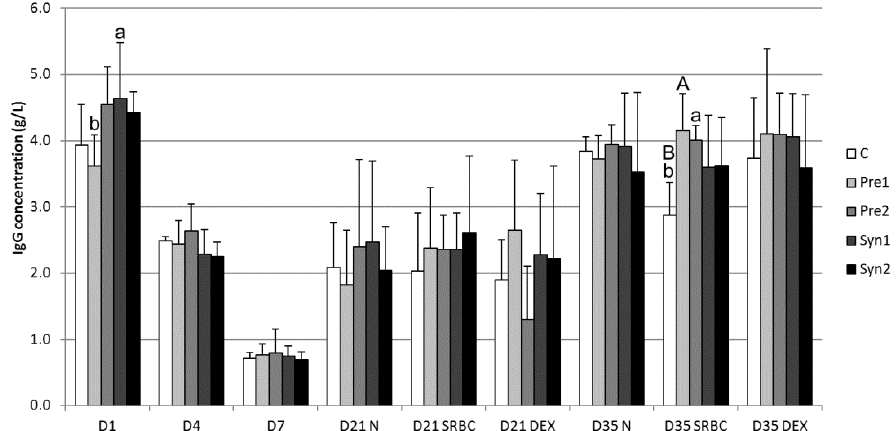
Figure 2. Serum IgG concentration (mean ± SD) in chickens between the 1st day (D1) after